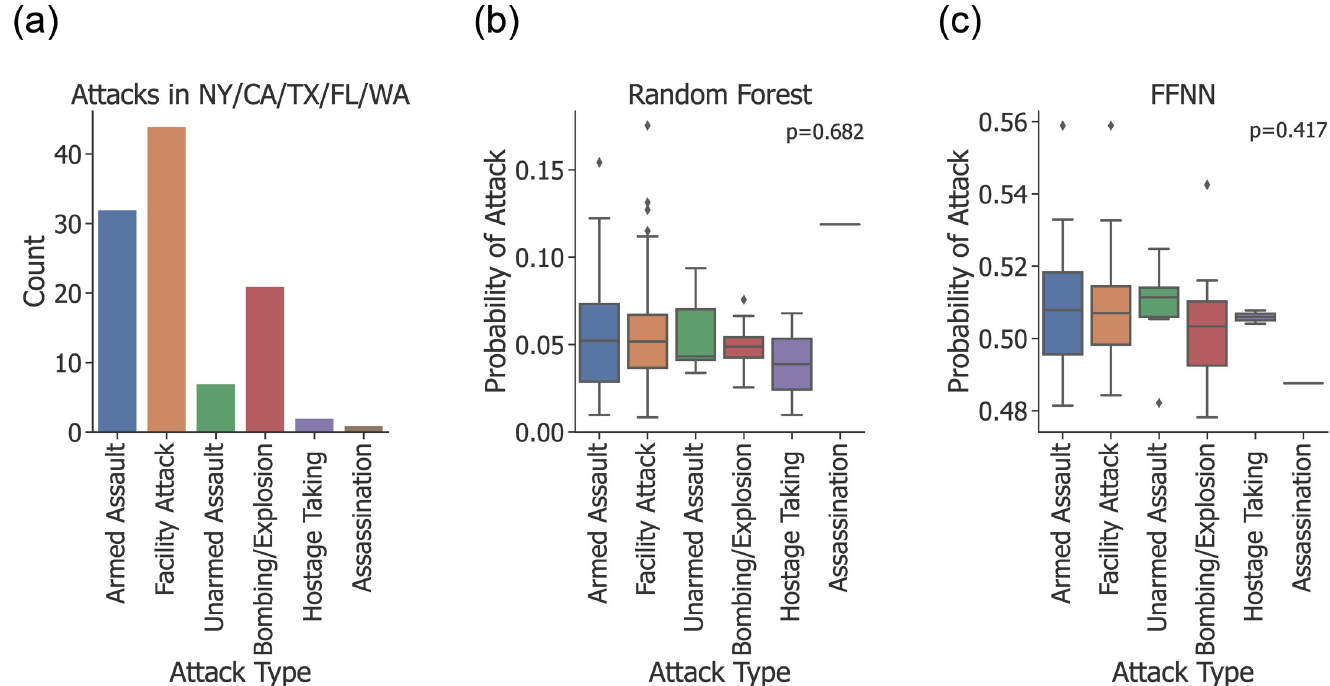
Fig 7. Distribution of event count and predicted probabilities ( P ( y = 1)) by attack type. The difference in scale in the y-axis between RF and FFNN is caused by differences in the training process for each model. In the box plots, each box represents observations within 1 standard deviation of the mean, which is represented by the horizontal line. Error bars represent observations within 3 standard deviations of the mean, while individual points represent outliers. ( a ) Distribution of attacks by type as recorded in the GTD. ( b ) Distribution of RF’s predicted probabilities. ( c ) Distribution of FFNN’s predicted probabilities.